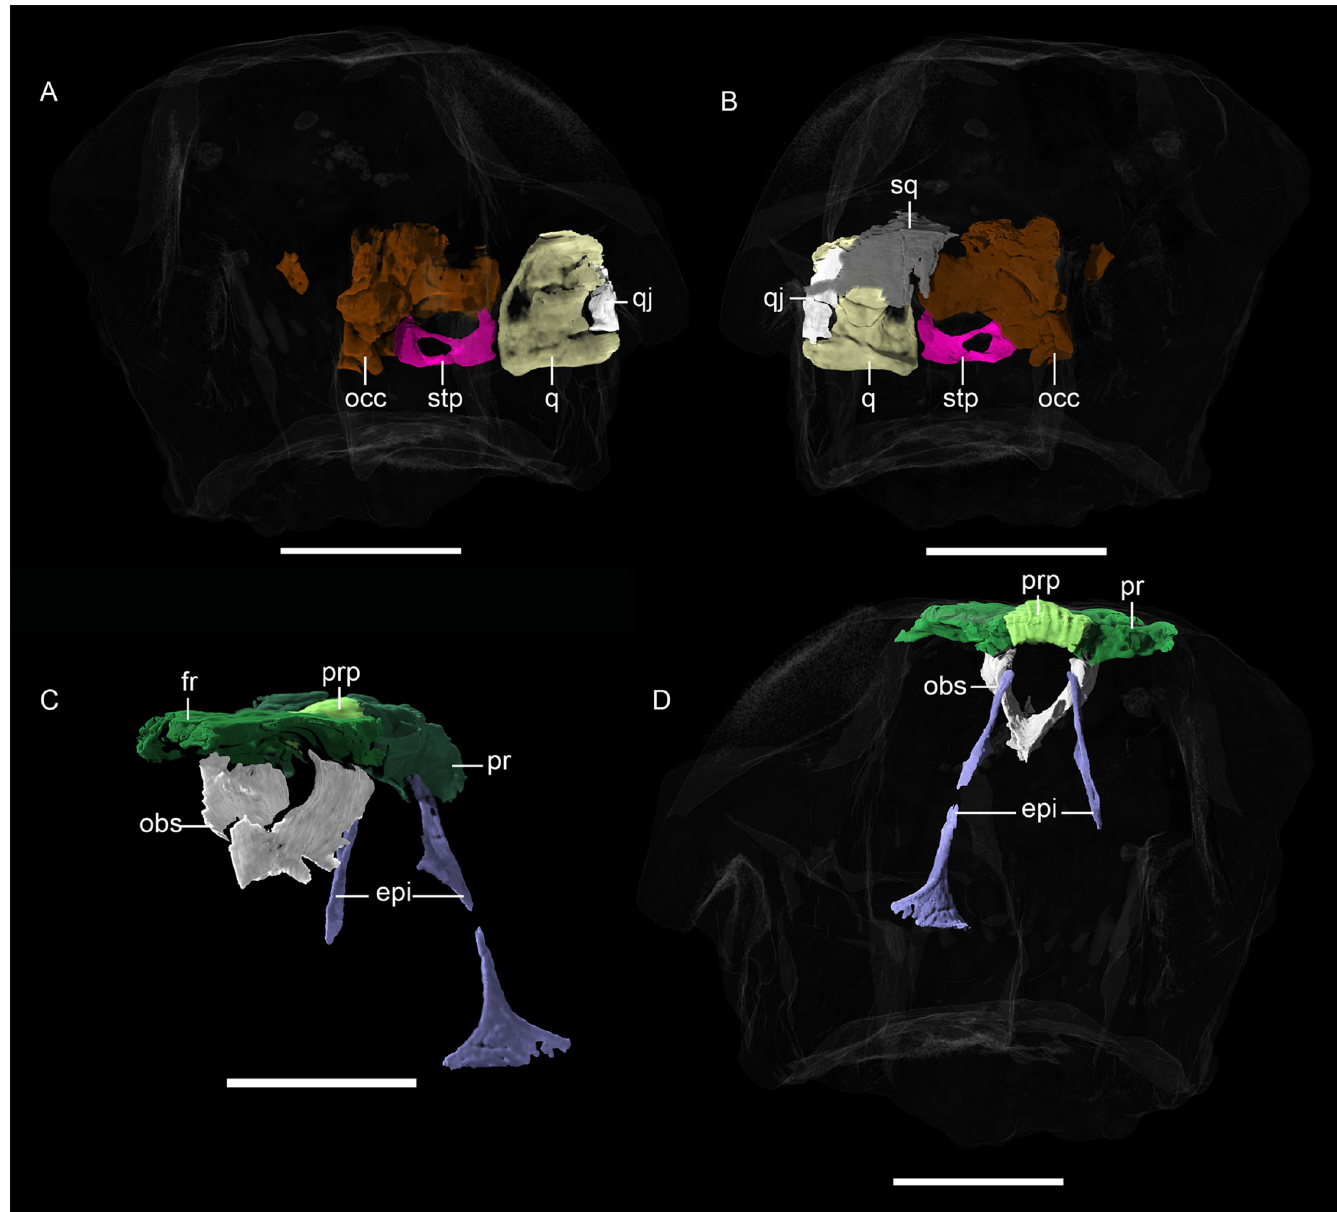
Fig 10. Neutron CT reconstruction of MB.R.999: occipital region from (A) anterior and (B) posterior; epipterygoid/orbitosphenoid from (C) anterolateral and (D) posterior. Abbreviations: epi, epipterygoid; fr, frontal; obs, orbitosphenoid; occ, fused occipital components; pr, parietal; prp, preparietal; q, quadrate; qj, quadratojugal; sq, squamosal; stp, stapes. Scale bars = 2 cm.